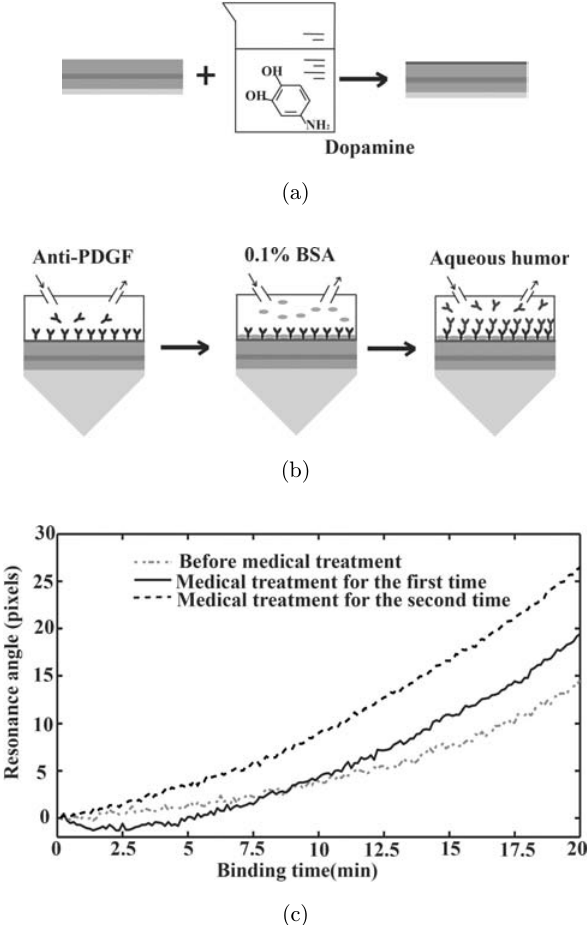
Fig. 4. Biomedical application experiments based on CPWR sensor. (a) Surface modi¯cation of the sensor chip by depositing polydopmine ¯lms on the MgF 2 layer. (b) Biological procession for the detection of PDGF in aqueous humor samples. (c) Time evolution of the sensing signals (shifts of resonance positions) responding to the binding procedure between PDGF and